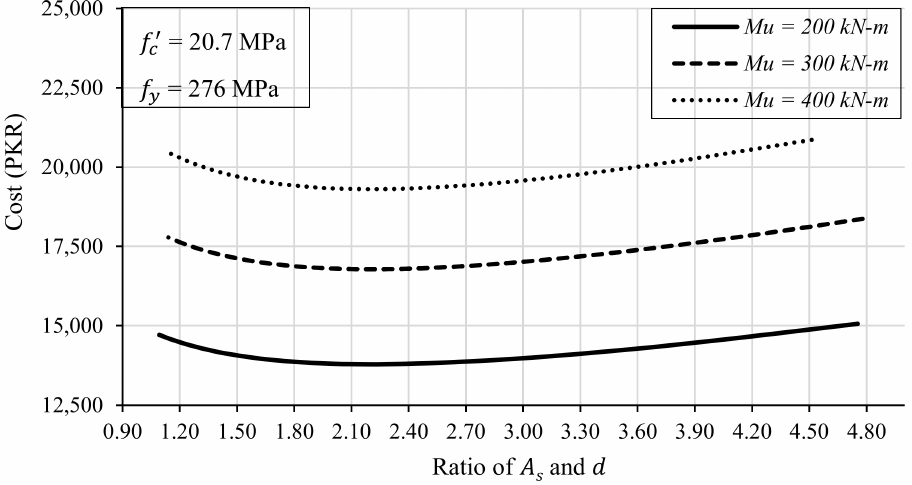
Figure 3. The effect of the ratio A s / d on the cost of the simply supported RC